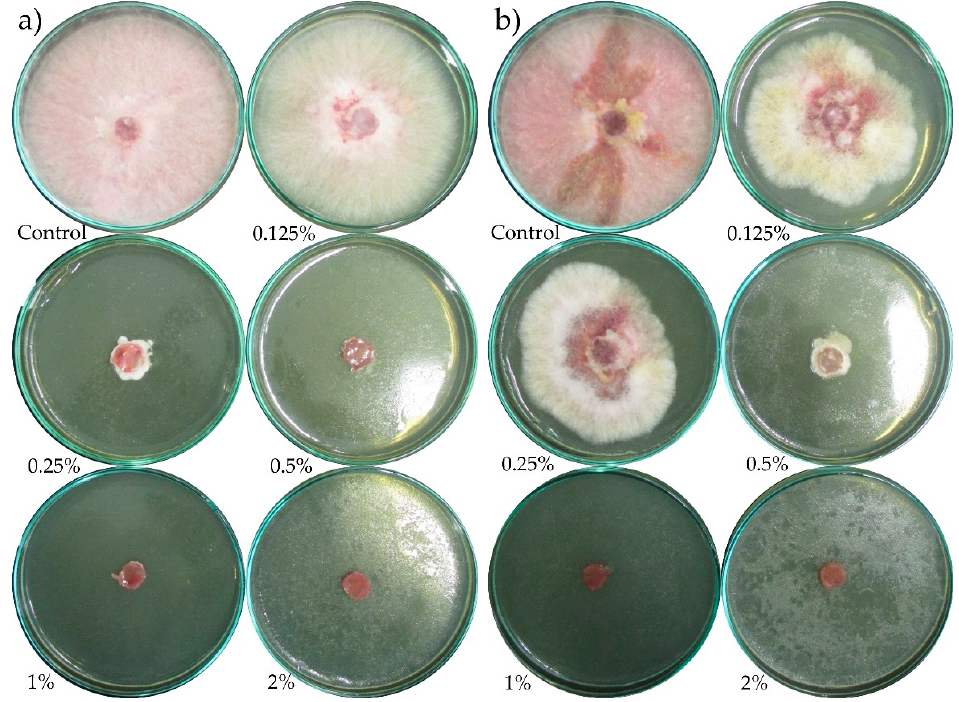
Figure A7. The effect of lemon oil concentrations on the growth of Fusarium graminearum ZALF 24 ( a ) and Fusarium graminearum ZALF 339 ( b ).